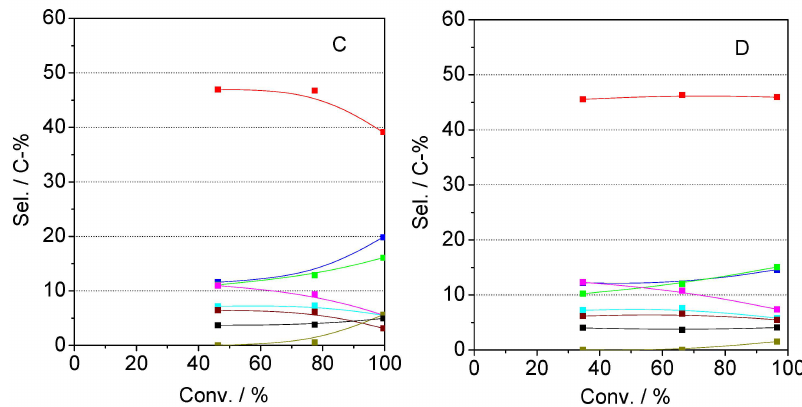
Figure 14. Changes in products’ selectivities with n -hexane conversion on HB(77) ( A ); HB(77)-NT(1 M, 1 h) ( B ); HB(77)-NT(2 M, 1 h) ( C ); and HB(77)-NT(2 M, 16 h) ( D ) catalysts. Reaction conditions: see Figure 12. Products abbreviations: see Figure 11.